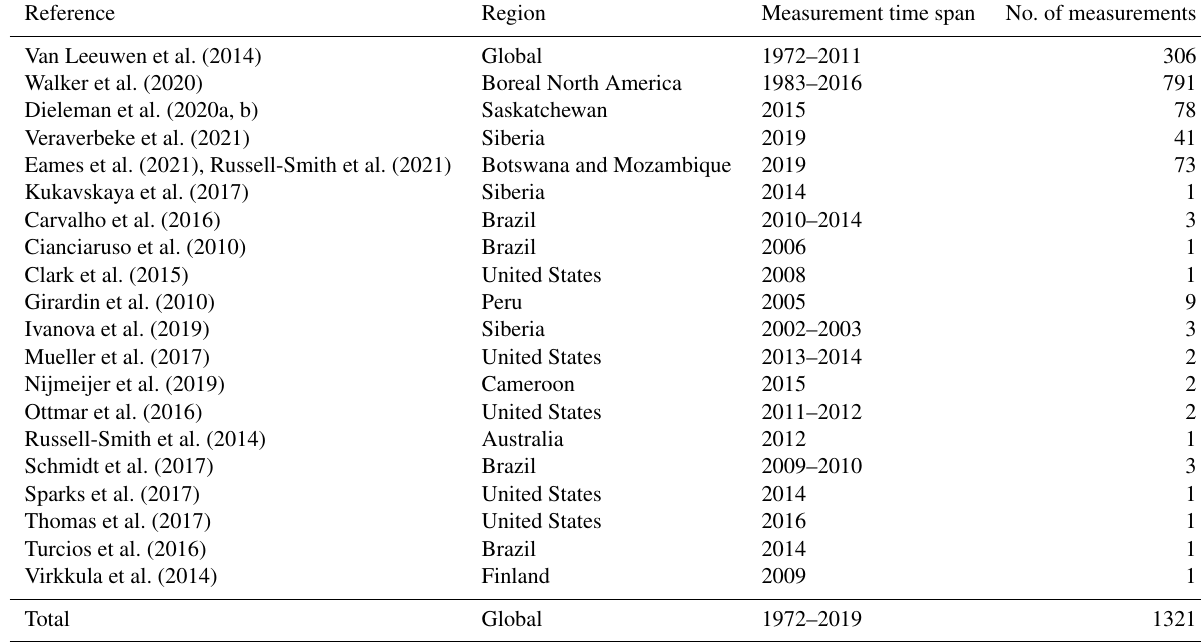
Table 2. Overview of reference data for field measurements of fuel load and fuel consumption for producing the updated synthesis database. Each measurement count represents a data entry of fuel load and/or fuel consumption for a measurement-specific set of fuel